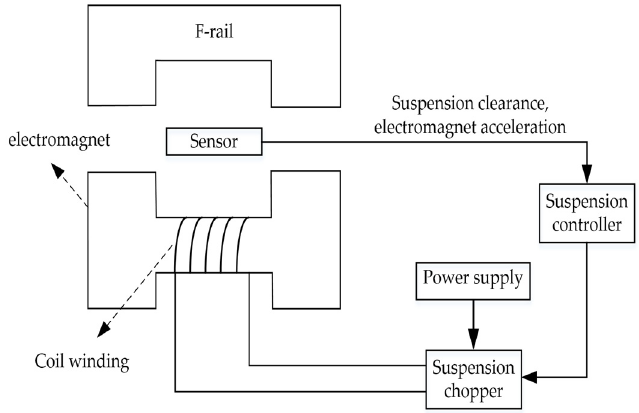
Figure 2. Physical model diagram of suspension system.